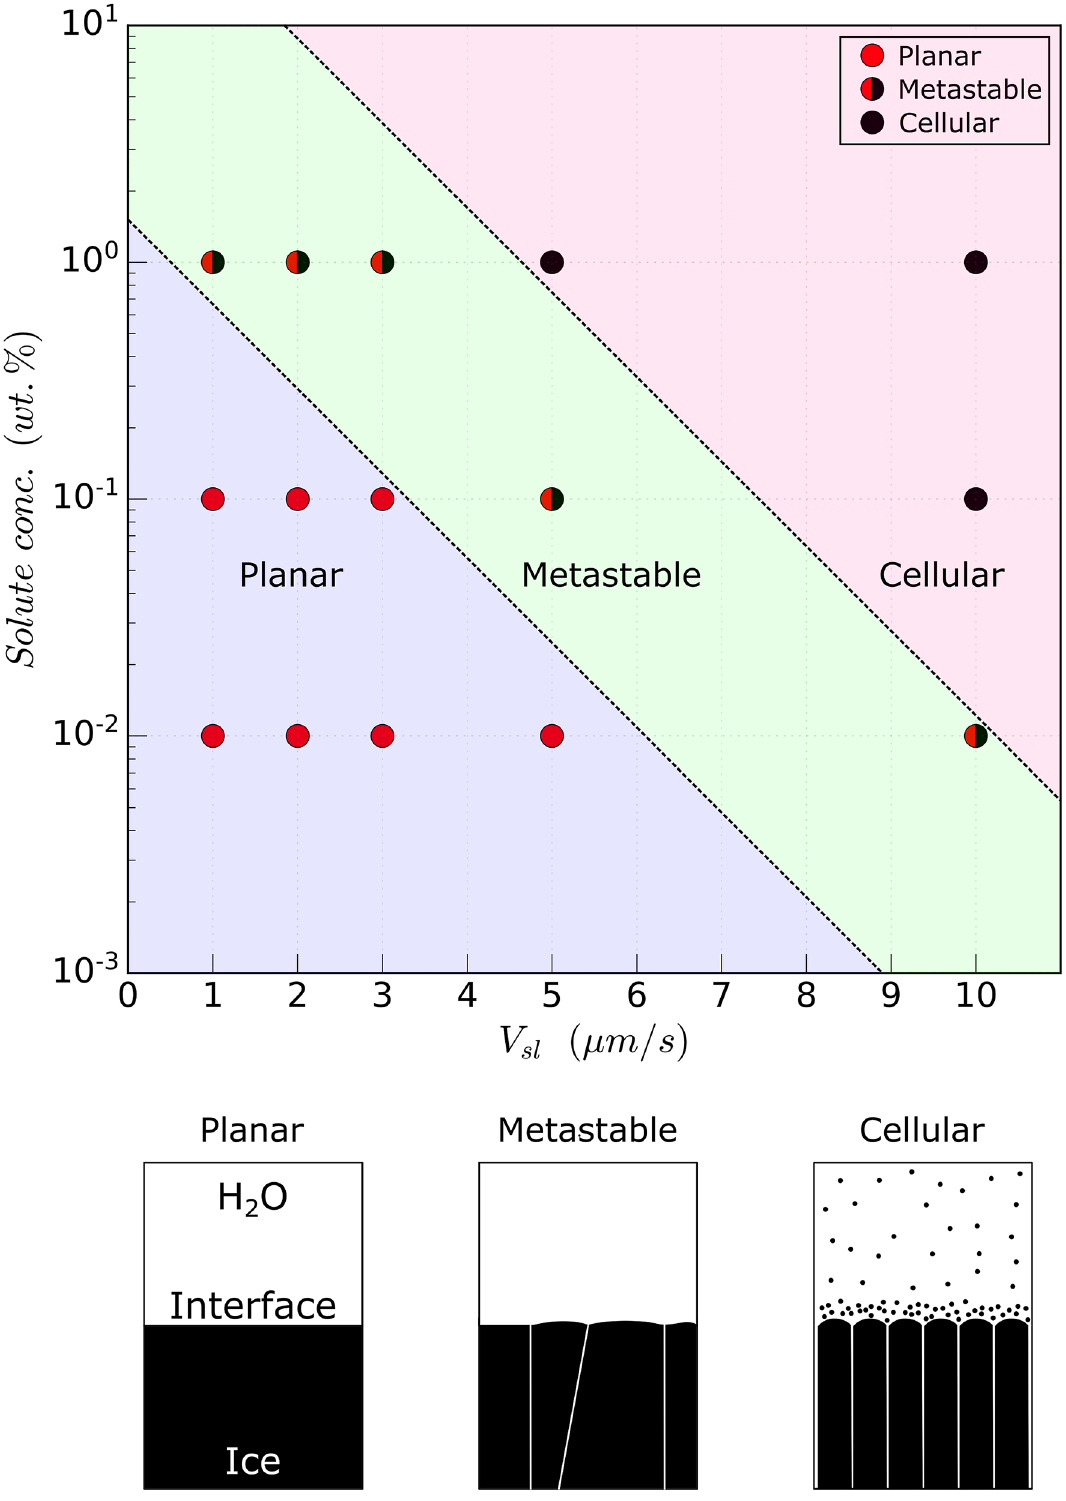
Figure 4. Front morphologies obtained during the directional solidification of an ice-water system in the solute concentration versus growth rate ( V sl ) plane, at a constant thermal gradient of 10 4 K m − 1 . A steady-state planar front gets destabilised partially, with an increasing growth rate and solute concentration, to a metastable front exhibiting a few cells boundaries, and eventually forms a cellular front for the higher solute concentrations ( ≥ 10 − 1 wt.%). Broken lines are drawn to differentiate the three zones distinctly and do not imply an extrapolation of the experimental data. © (2020) S. Tyagi et al. (10.6084/m9.figshare.13176221) CC BY 4.0 license https ://creat iveco mmons .org/licen